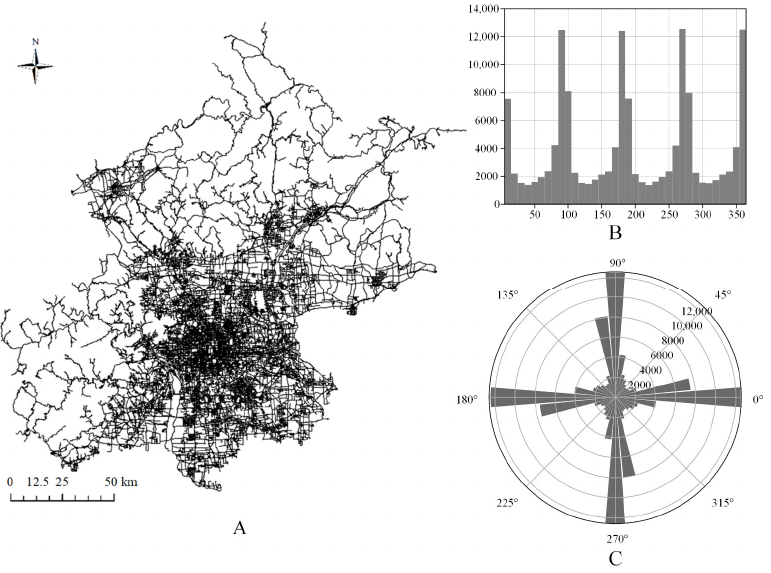
Figure 2. ( A ) Street network in Beijing. ( B ) Street orientation histogram of Beijing, where the horizontal coordinates indicate the orientation angles, and the vertical coordinates indicate the frequency of a street falling into the corresponding bin. ( C ) Street orientation rose illustration of Beijing, where the outer side of the circle represents the street orientation, and the inner data are the same as the vertical coordinate in ( B ).